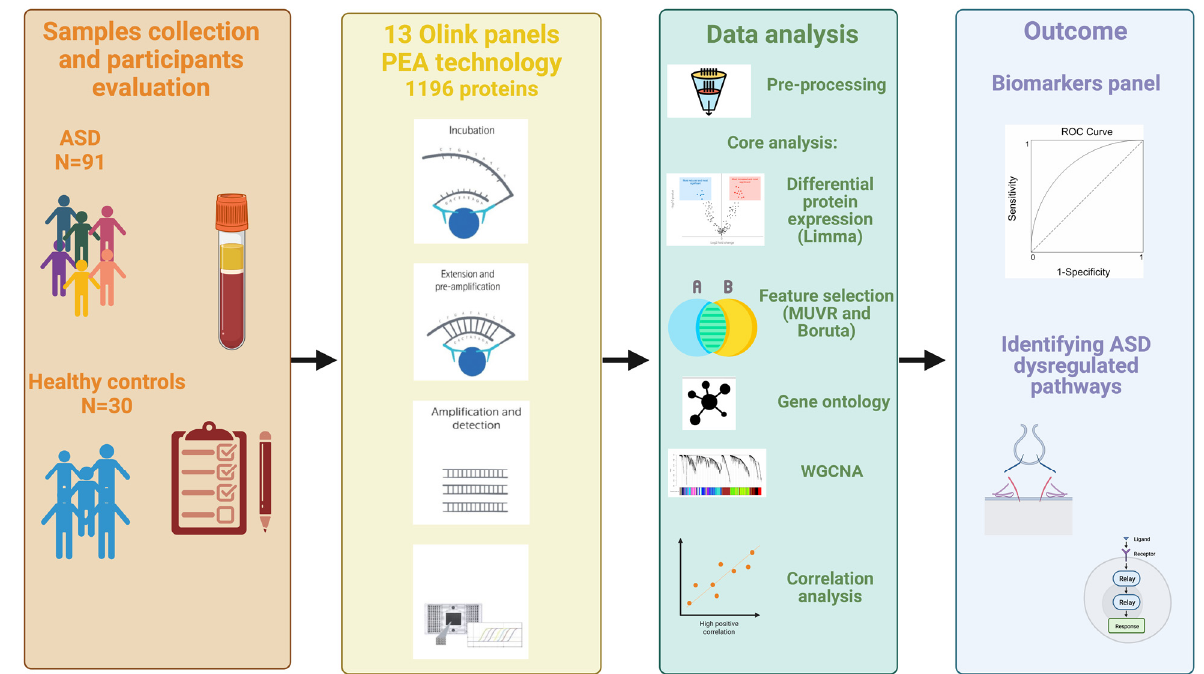
Figure 1. Study overview. Serum samples from 91 ASD cases and 30 healthy controls (HCs) were collected along with the participants’ demographical information. The serum samples were analyzed using 13 Olink target panels. Different bioinformatic and statistical analysis approaches were deployed for blood proteome profiling to identify potential biomarkers for ASD diagnosis and dysregulated pathways. (Created with www.BioRender.com (accessed on 18 March 2023).) Table 1. Participants’ demographical information summary. ASD Cases Healthy Controls